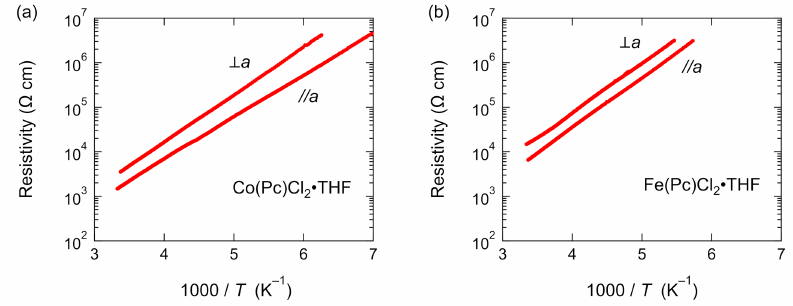
Figure 7. Temperature dependences of the electrical resistivities of ( a ) Co III (Pc)Cl 2 · THF and ( b ) Fe III (Pc)Cl 2 · THF along the a -axis ( // a ) and perpendicular to the a -axis ( ⊥ a ), as measured by